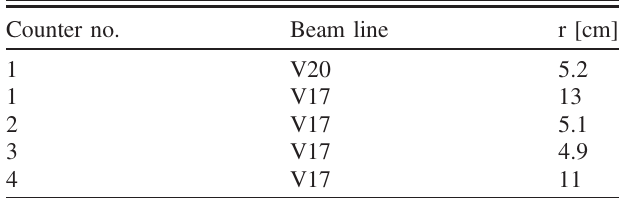
TABLE II. The distances of the 3 He proportional counters from the center of the foil/Beam on V17 and V20. Counter no.